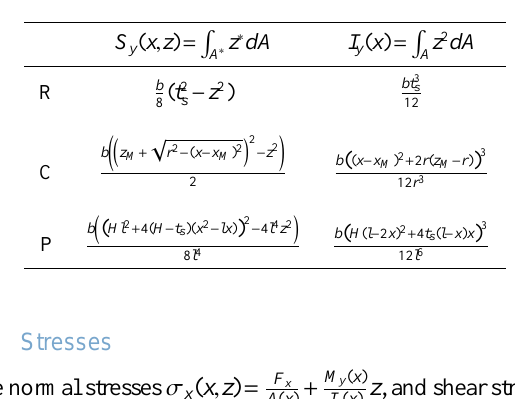
Table 1. First and second moments of areas of rectangular (R), circular (C) and parabolic (P) flexure